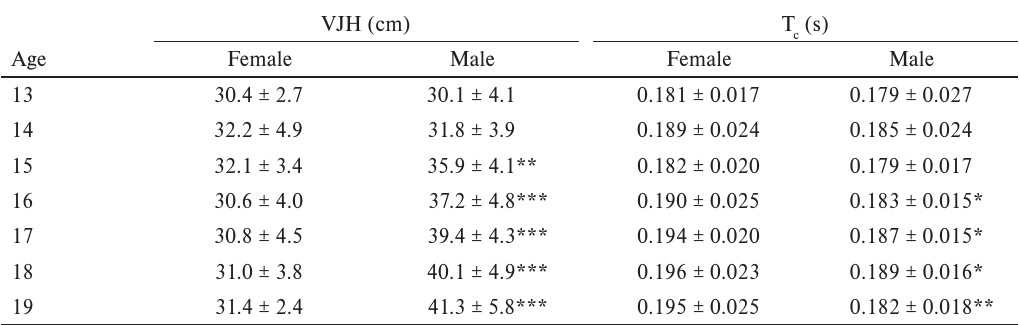
Vertical jump height (VJH) and ground contact time (T Values are presented as mean ±